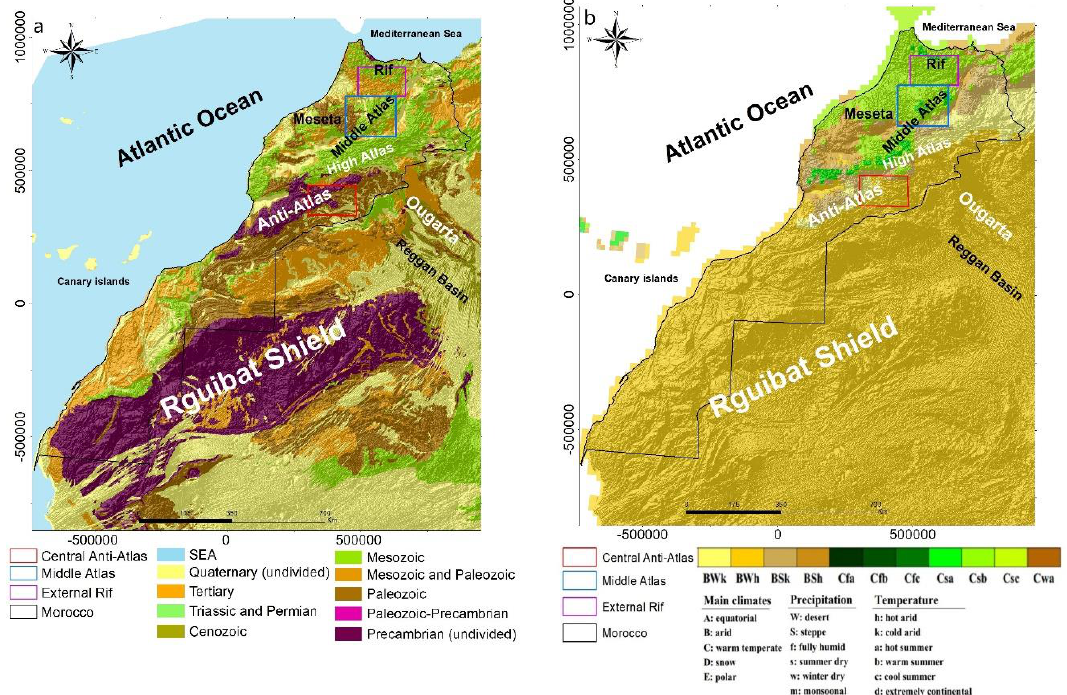
Figure 1. Location of the three study areas on ( a ) the geological context of Morocco provided by the United States Geological Survey (USGS) and modified from Kottek et al. [15], and ( b ) the köppen-geiger climate classification map of Morocco [16], superimposed on the global hill-shading image, Lambert conformal conic coordinates in m.